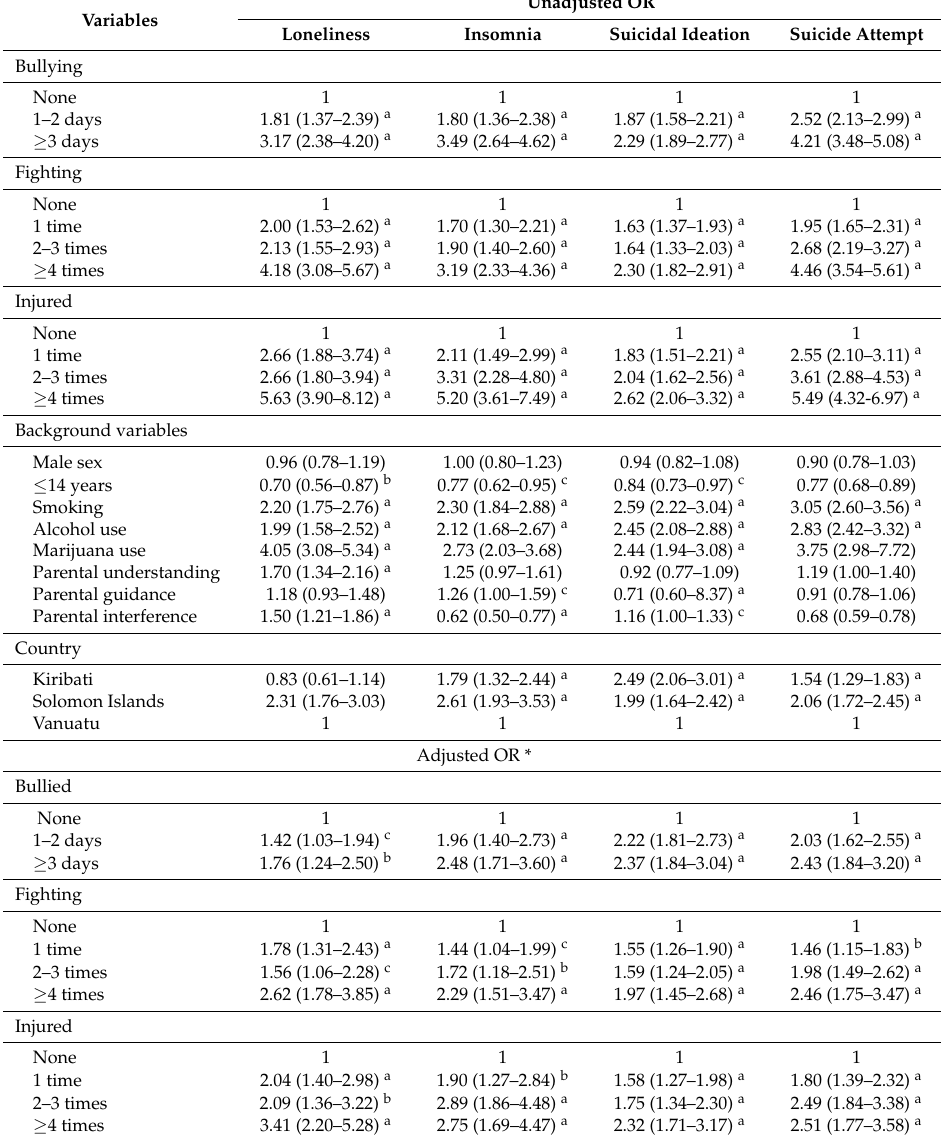
Table 4. Association of being bullied, in fight, and injury with psychological health outcomes. Unadjusted OR Variables Loneliness Insomnia Suicidal Ideation Suicide